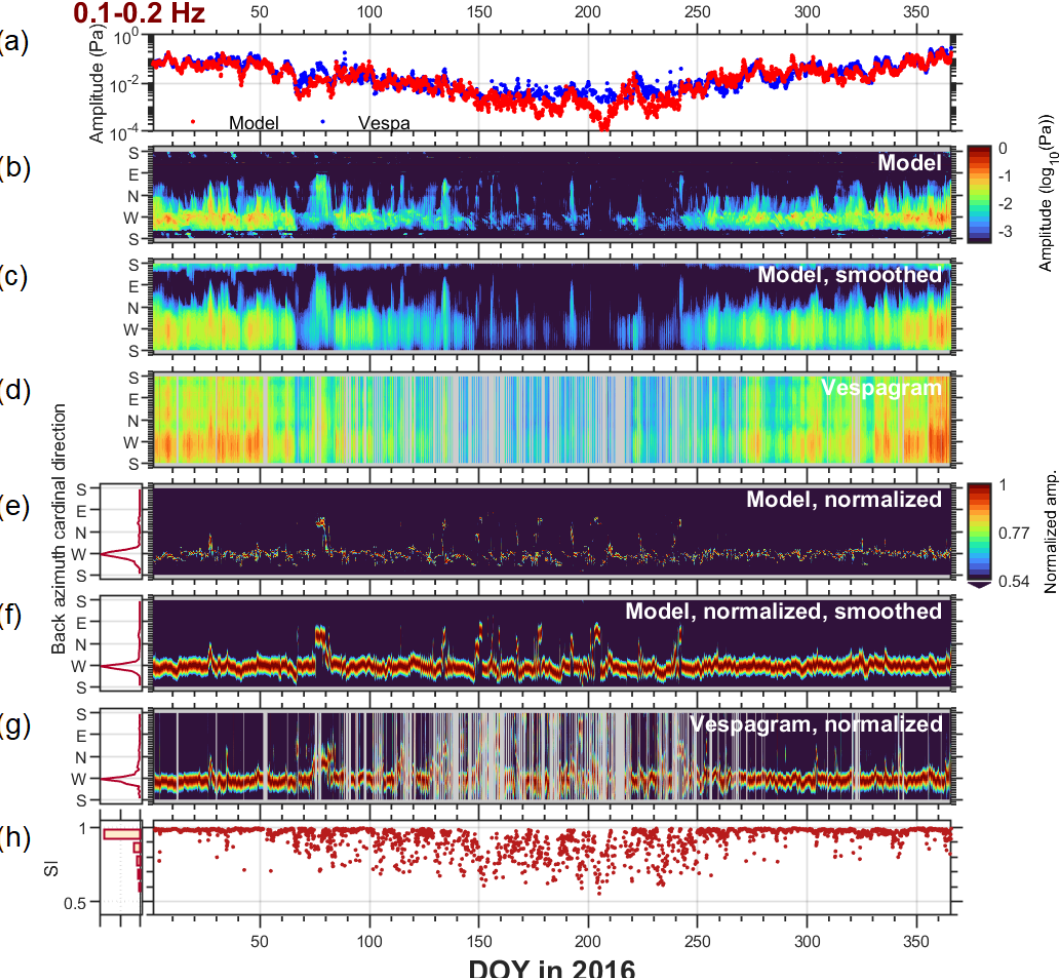
Figure 3. Benchmarking microbarom model and infrasound vespagram for 0.1–0.2Hz in 2016 for the IS37 station. (a) Amplitude of the dominant signal (blue – vespa processing; red – model). (b) The base 10 logarithm of the model amplitude. (c) The base 10 logarithm of the smoothed model amplitude (Sect. 2.2). (d) The base 10 logarithm of the infrasound vespagram amplitude (Sect. 2.1). The right-hand side panels in (e–g) are the same as panels (b–d) but after normalization by the maximum amplitude at each time step. The left-hand side panels in (e–g) show the normalized directional distribution of the dominant signal (10 ◦ bins). Panel (h) shows the similarity index between panels (f) and (g) (right) and the normalized distribution (left). Panels (b–d) have a common color bar, as do panels (e–g) . Gray fields indicate periods where infrasound data are disregarded due to noise and an indistinct directional spectrum. Panels (b–g) are visualized using the Turbo color map (Mikhailov,